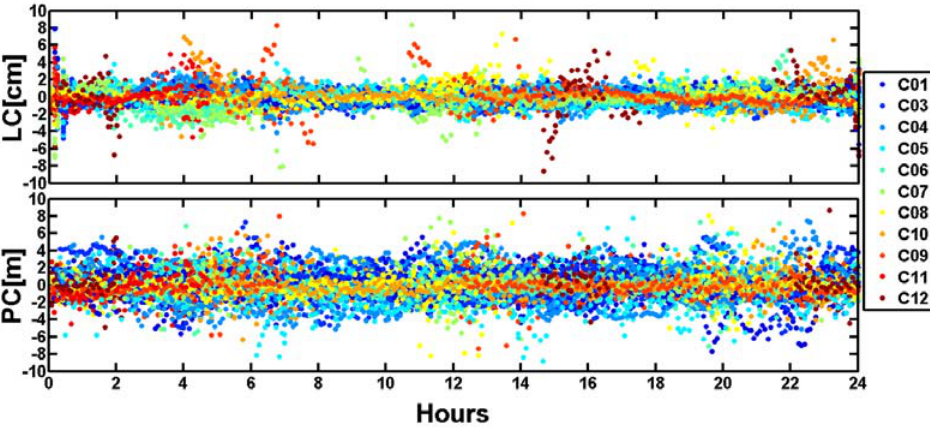
Figure 11. Undifferenced LC and PC residuals of BeiDou satellites.